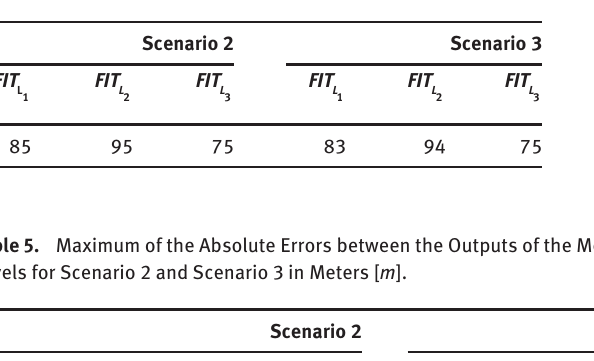
Table 4. FIT Indicators for Scenario 2 and Scenario 3 (%).